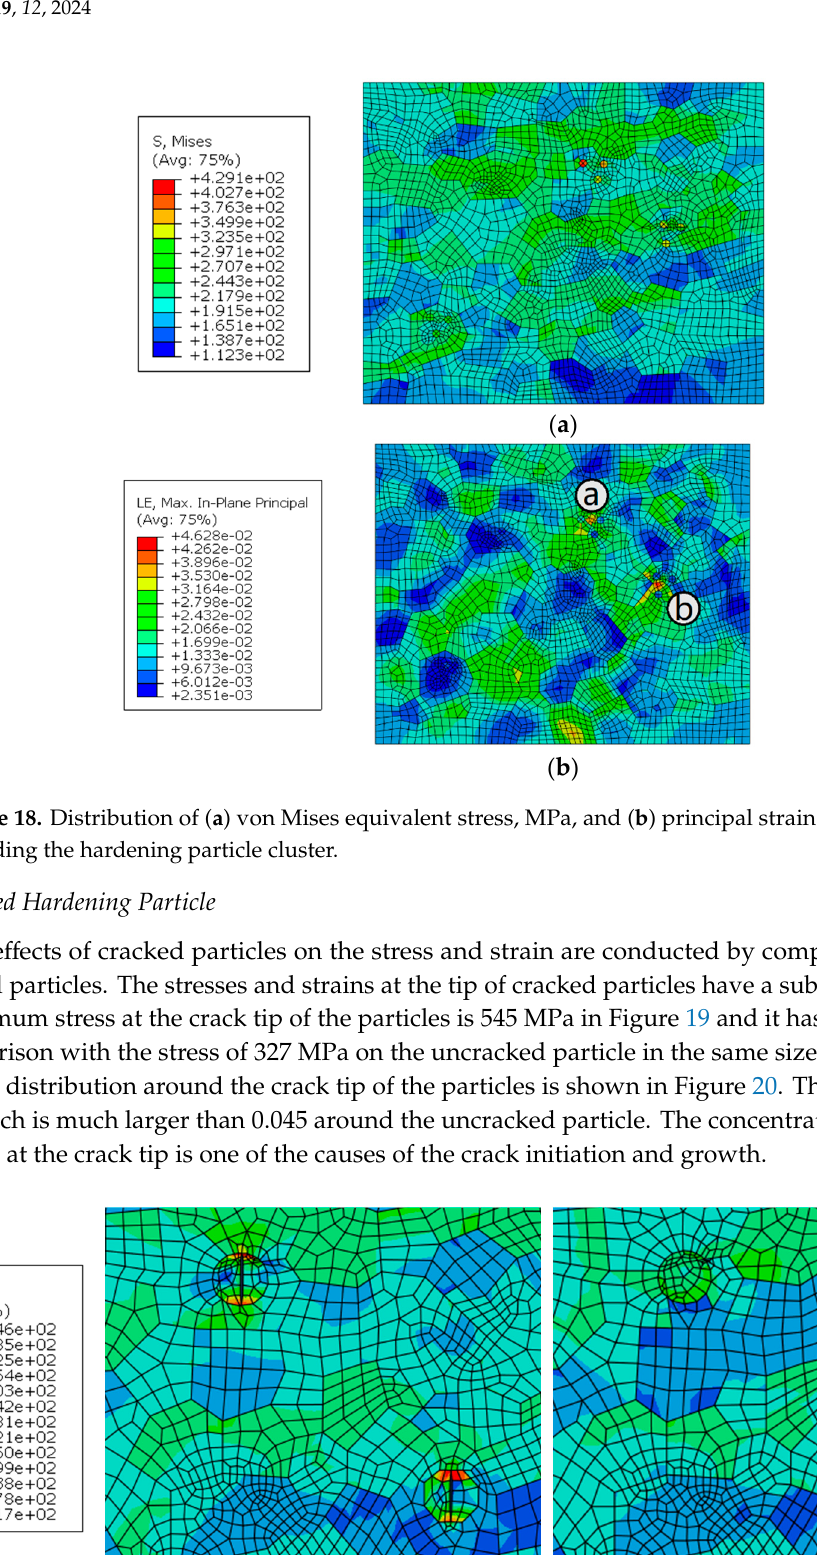
( b ) Figure 20. Distribution of principal strain in the WNZ including ( a ) cracked particles and ( b ) uncracked particles. 6. Conclusions 1) The joint macroscopic model is composed of different zones that have different properties. The simulation shows that the fatigue weak area is gradually close to the WNZ from the BM with an increase of loading stress. 2) The macro-mesoscopic joint model containing the hardening particles and the crystal characteristics is established with different settings for the material properties of particles and grains. 3) The responses of local stress and strain in the WNZ are analyzed from the status of the slip system activation, grain misorientation, particle size, particle cluster, and cracked particles. The stress transfer occurs at the grain boundaries with low-angle misorientations. Clustering of hardening particles is prone to cause the strain increase and the cracked particles also make the local stress and strain an apparent rise.